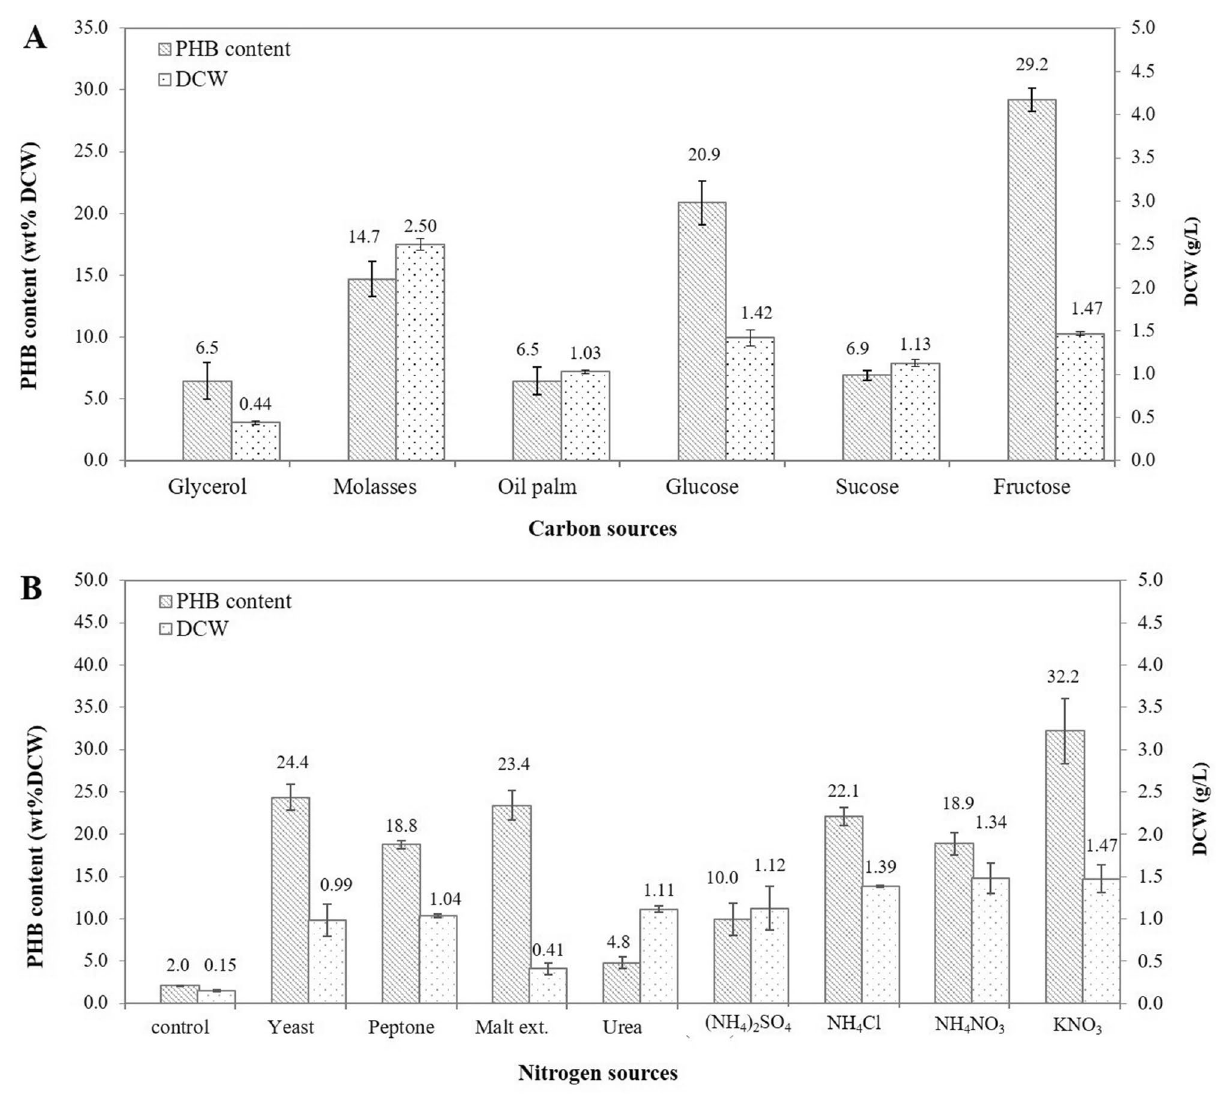
Figure 2. Poly-β-hydroxybutyrate (PHB) production by Rhodococcus pyridinivorans BRST1-1 using different carbon and nitrogen sources in shake flask